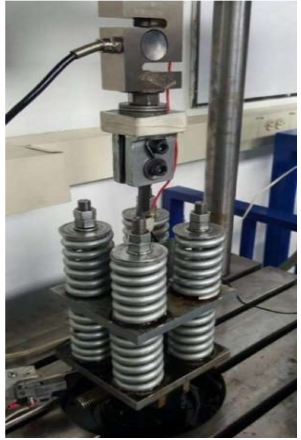
Figure 2. Specimen mounted on the uniaxial fatigue